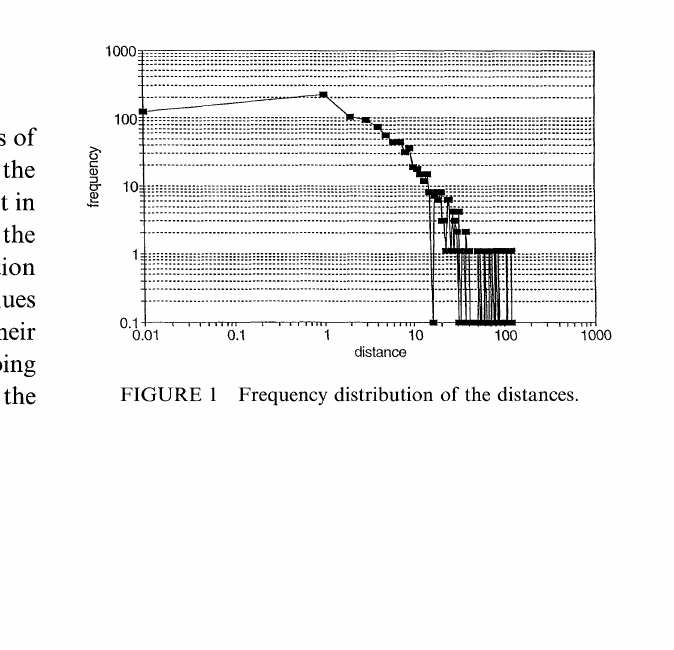
FIGURE Frequency distribution of the